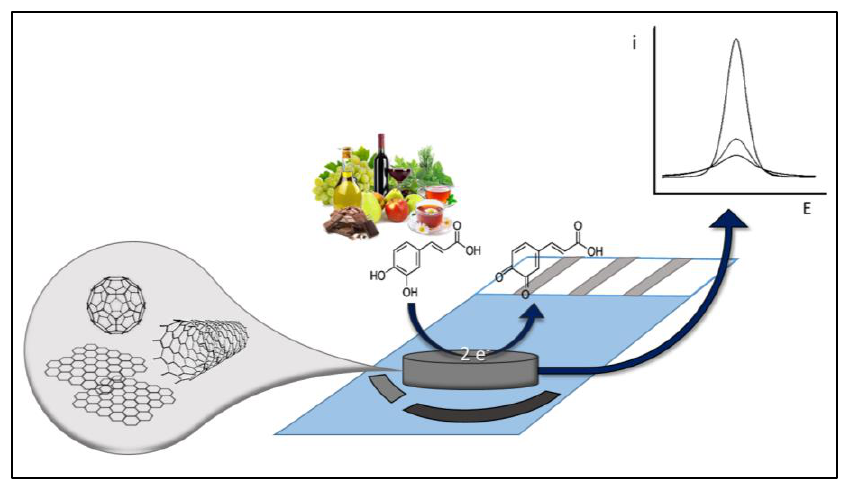
Figure 2. Schematic representation of polyphenols oxidation onto a nanomaterial based electrode.